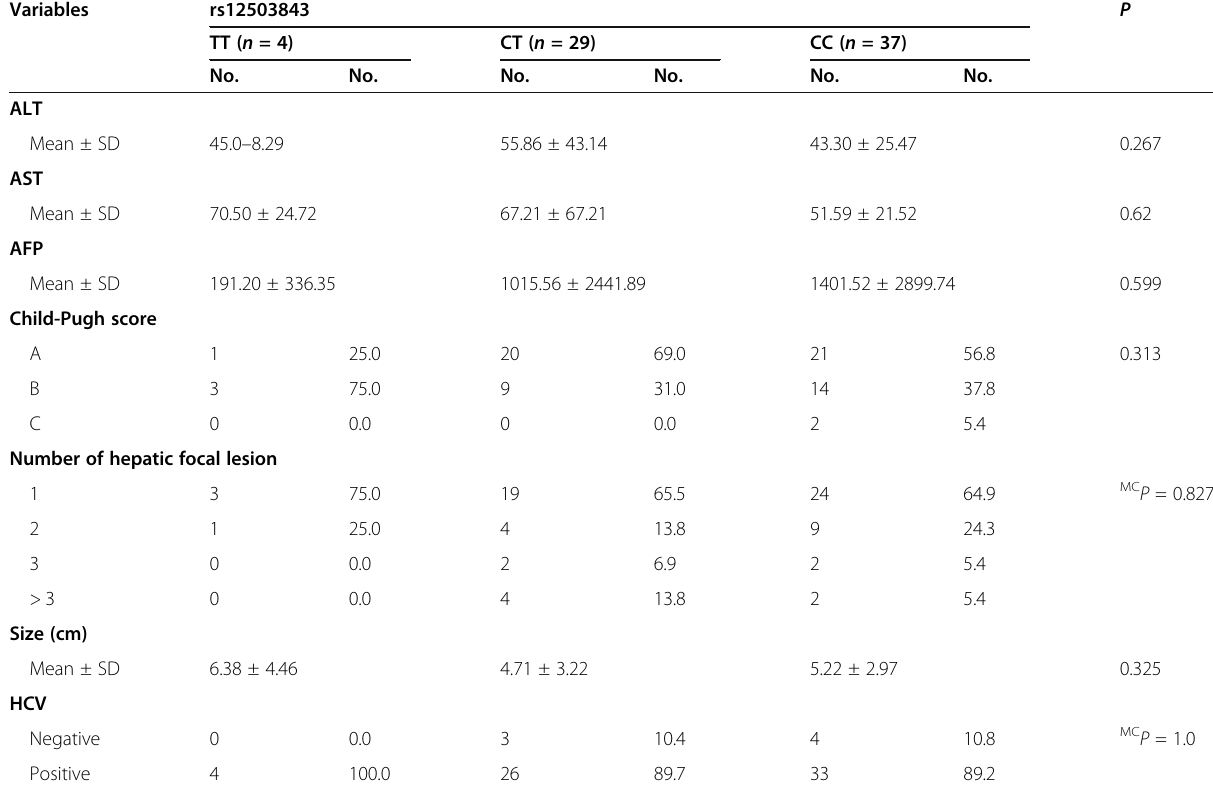
Table 5 Association between rs12503843 and clinicopathological markers